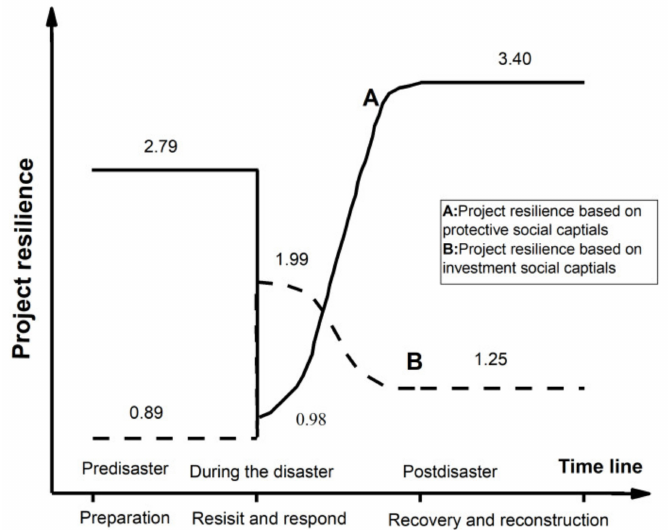
Figure 4. Construction project resilience in the three phases of the